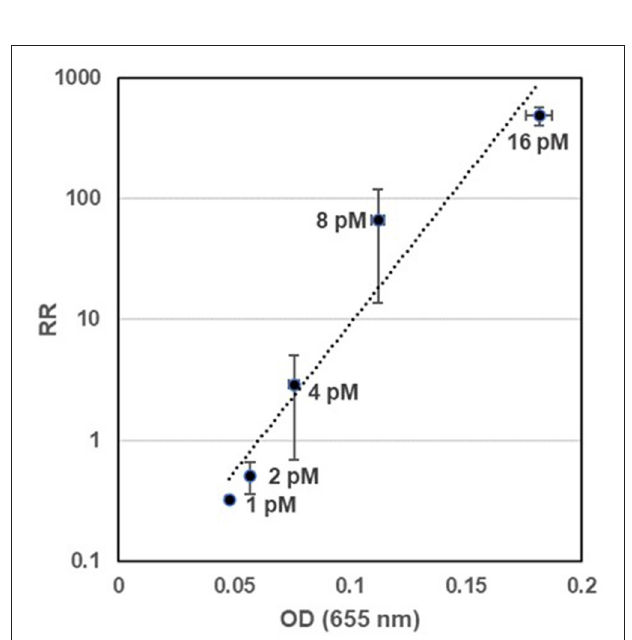
FIGURE 3 | Comparison of electrochemical and colorimetric measurements of HRP activity. HRP–TMB reaction was measured using the optimized electrochemical method and a conventional colorimetric method [measurement of the optical density (OD) at 655nm] at different HRP concentrations. HRP concentrations (pM) used in the experiment were indicated next to each dot. The experiment was conducted with three replicates. A similar result was obtained in a separate experiment.